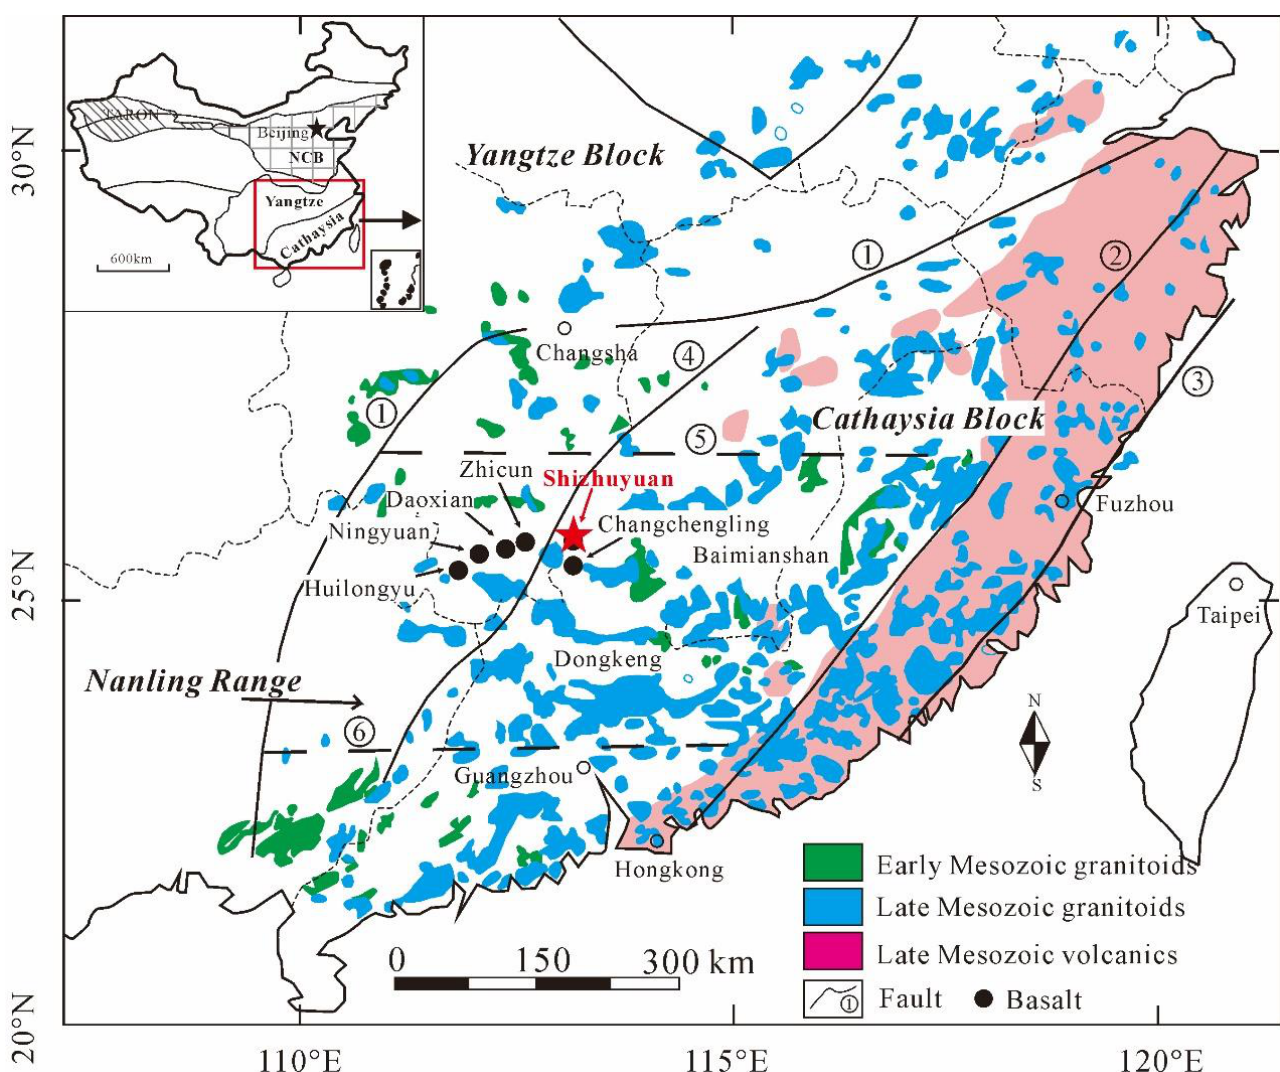
Figure 1. Geological map of the Nanling Range, South China (modified after [2,27]). Faults: (1) Jiangshan–Shaoxing–Pingxiang Fault; (2) Zhenghe–Dapu Fault; (3) Changle–Nan’ao Fault; (4) Chenzhou–Linwu Fault; (5) Changlin–Guangchang buried Fault; (6) Wuzhou–Sihui buried Fault.